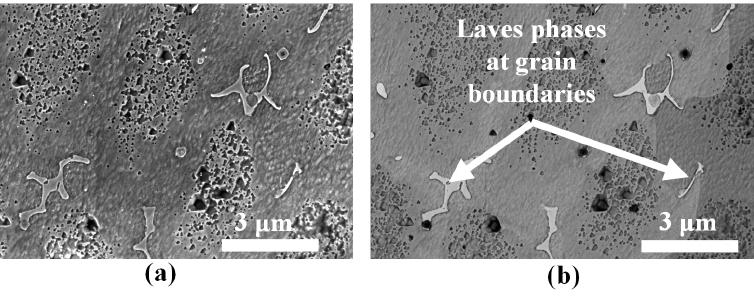
Figure 10. ( a ) SEM image of a representative region in the powder-fed specimen showing Laves phases morphology at the grain boundaries. ( b ) The corresponding backscatter image of the region. Here the Laves phase appear lighter since they are composed of a heavier element